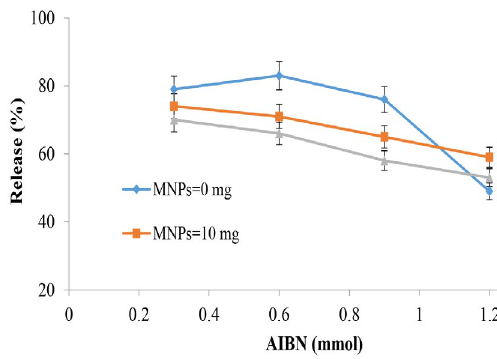
Fig. 9. Effect of AIBN amount on the release of